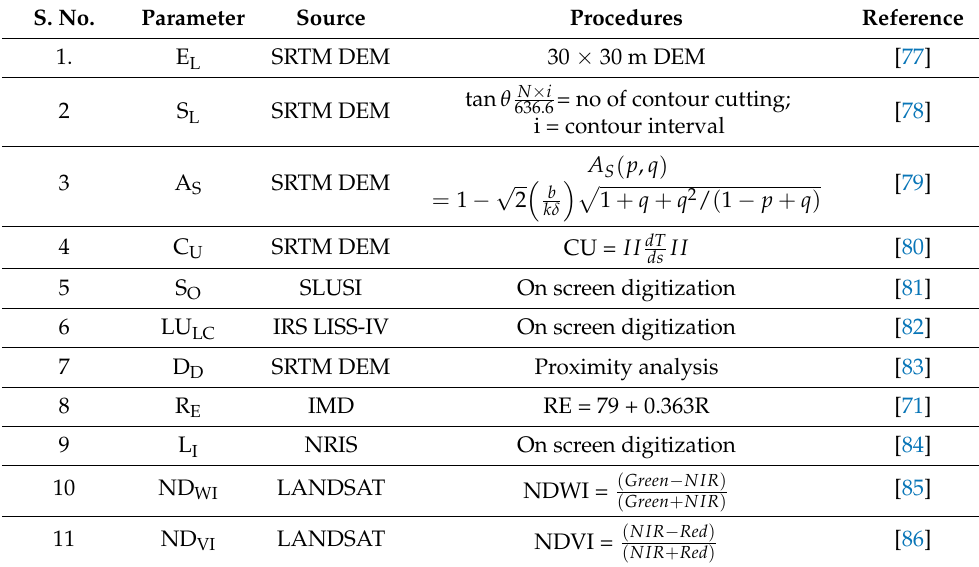
Table 1. Data sources and techniques used for the preparation of thematic data layers. S. No. Parameter Source Procedures Reference